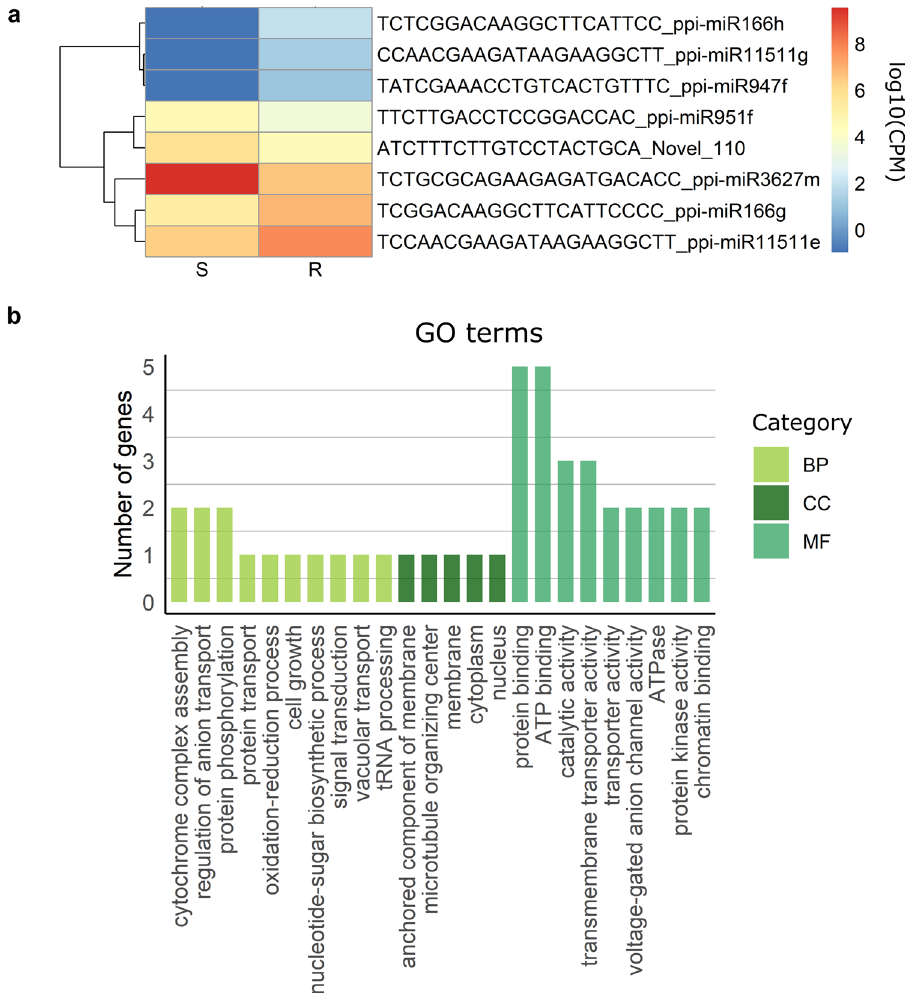
Figure 3. MiRNAs differentially expressed between resistant (R) and susceptible (S) plants ( a ) and functional analysis of their target genes ( b ). ( a ) The heatmap represents average log10(CPM) values for each miRNA. ( b ) GO terms represented in the predicted target genes for the DE miRNAs. The y-axis represents the number of genes within each GO terms. BP biological process, CC cellular component, MF molecular function. Plots were generated with R 4.1.0 (https:// cran.r- proje ct. org/) pheatmap package (https:// cran.r- proje ct. org/ web/ packa ges/ pheat map/) and ggplot2 package (https:// ggplo t2. tidyv erse. org/). Inkscape 1.1 (https:// inksc ape. org/) was used to assemble the final